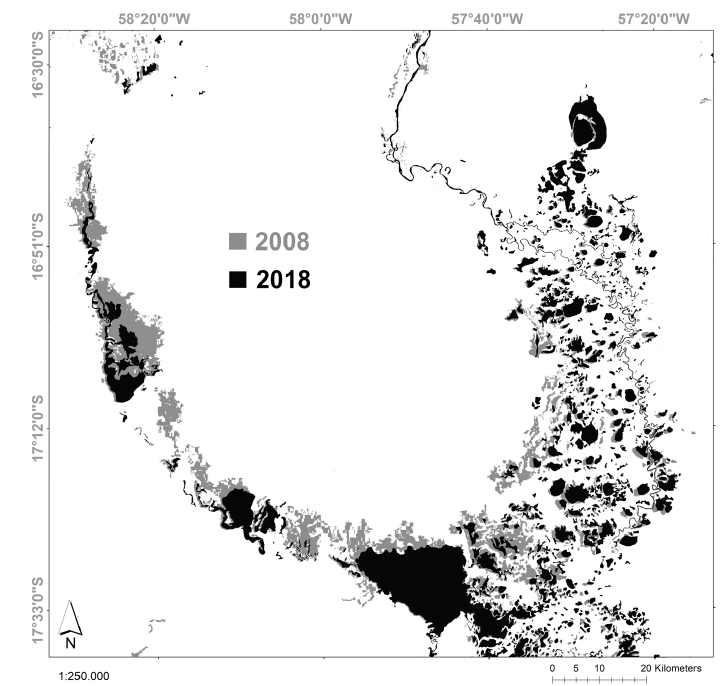
Figure 3. Water mass area in 2008 (grey) and in 2018